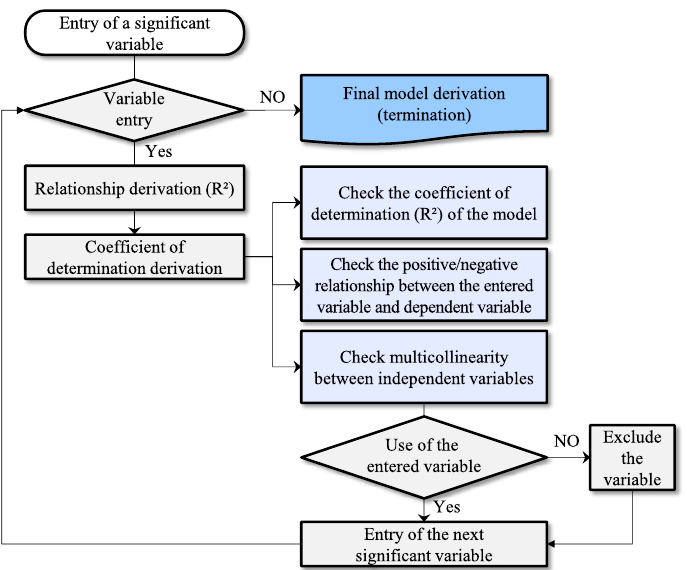
Figure 2. Process of deriving a multiple regression equation (step-wise method).